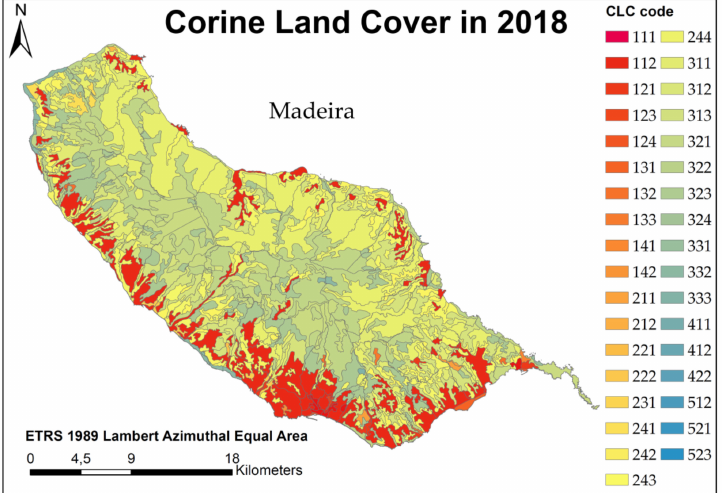
Figure 12. Thematic cartography regarding the land-use changes in the Madeira Archipelago in the year 2018.